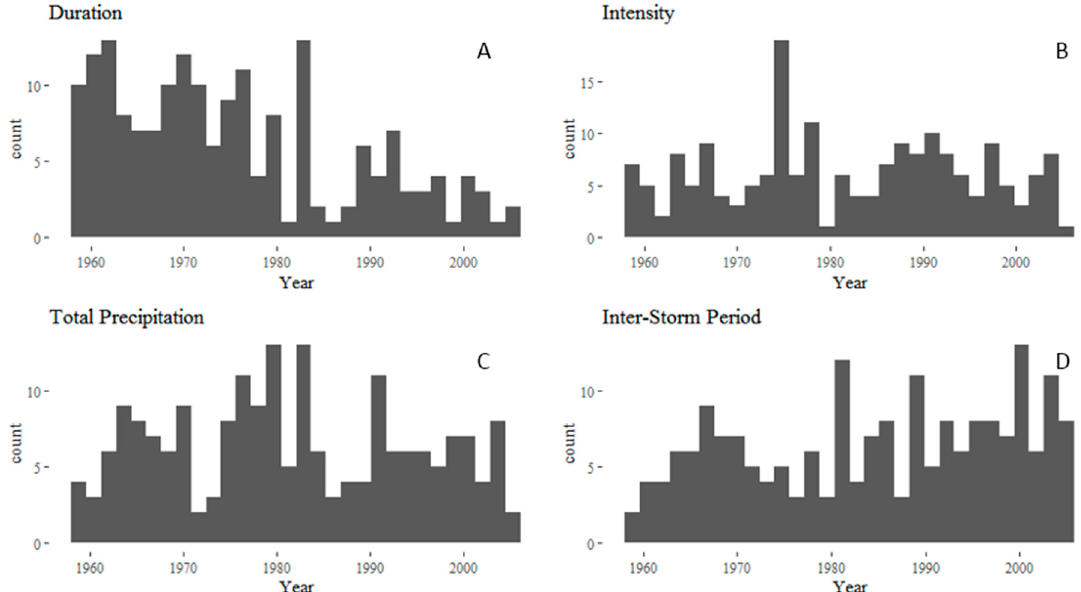
Figure 3. Histogram of different extreme events and their occurrences over time to show the frequency of occurrence for extreme events during the study period. Each sub figure shows this for each storm property: Duration ( A ), intensity ( B ), total precipitation ( C ), and inter-storm period ( D ).